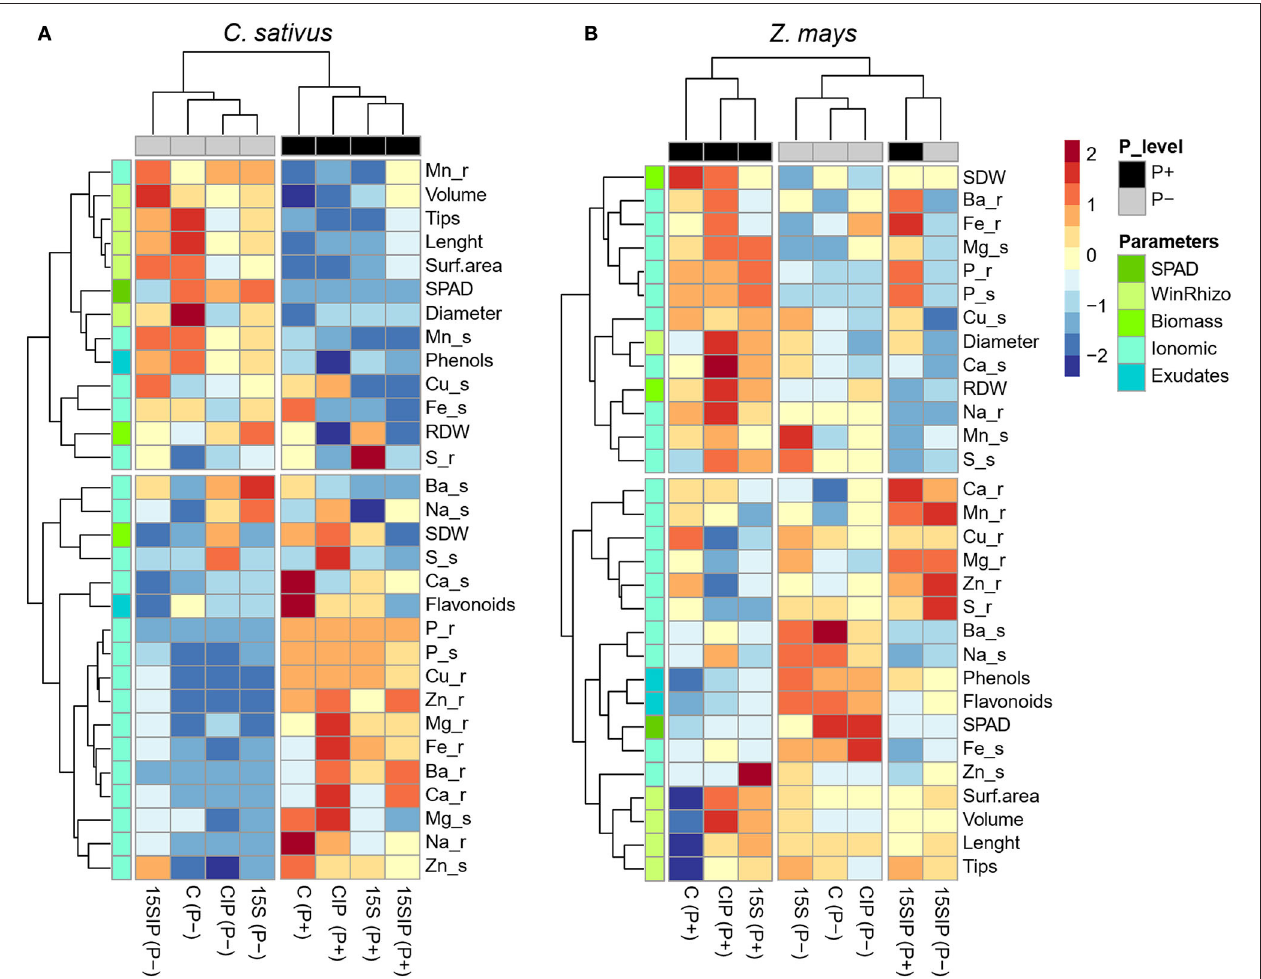
FIGURE 6 | Heatmap analysis summarizing the responses of the cucumber (A) and maize (B) plants to a factorial experiment with two P-fertilization levels (P + and P) and four biostimulant treatments (15S; 15SIP; C, uninoculated control; CIP). The heatmap was generated using the R software (https://www.r-project.org, using the “pheatmap,” “ggplot2,” and “RColorBrewer” packages). Hierarchical clustering was performed with Complete linkage and Manhattan distance was used as the similarity measure. Dark red color indicates higher relative values, while a dark-blue color reflects lower relative values. Yellow color denotes values close or equal to zero, i.e., close or equal to the mean for each